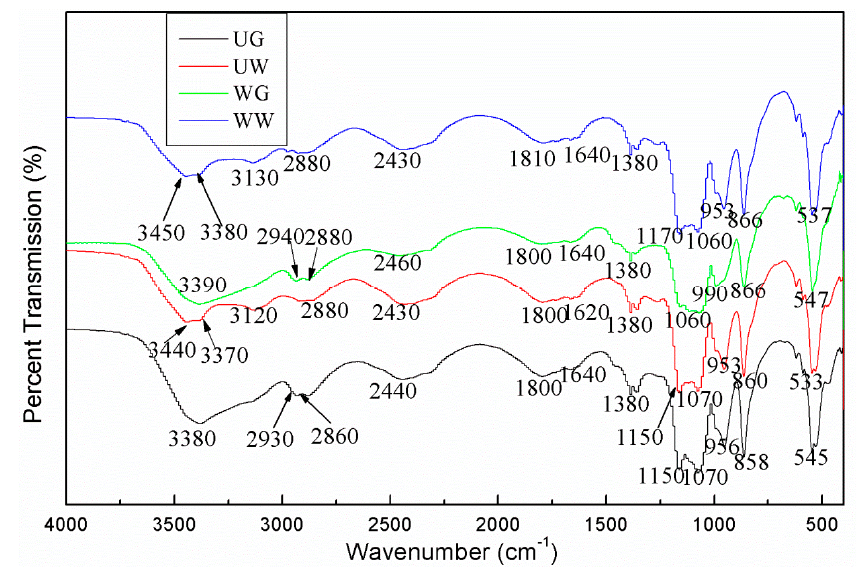
Figure 4. FTIR of LSP extract with four different